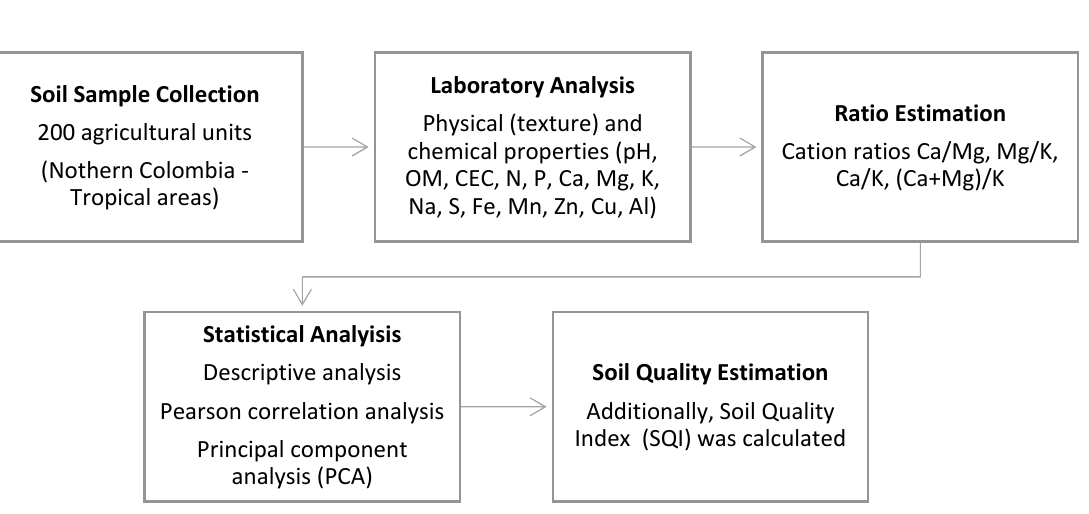
Fig. 1: Scheme of the methodology used in this study.